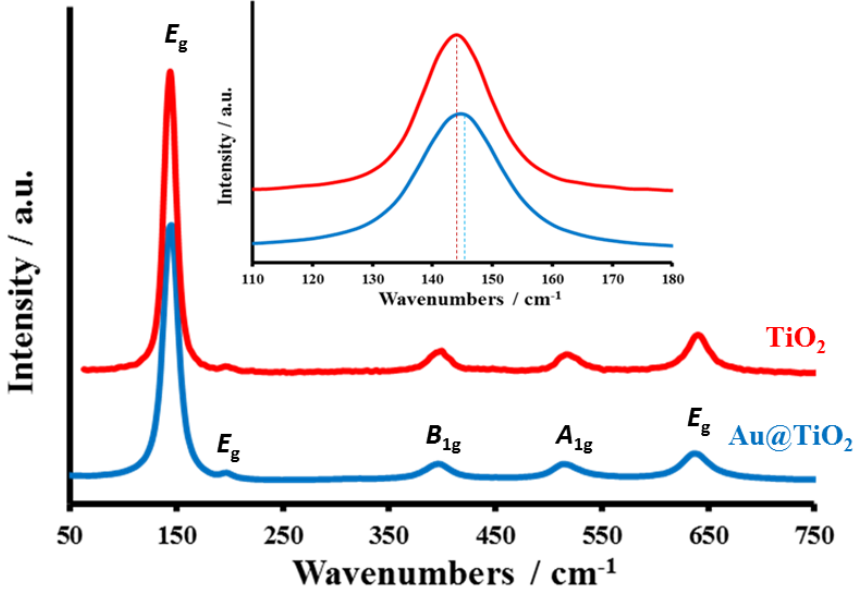
Figure 2. Raman spectra of the prepared TiO 2 and Au@TiO 2 (Au is 8.14%) materials.